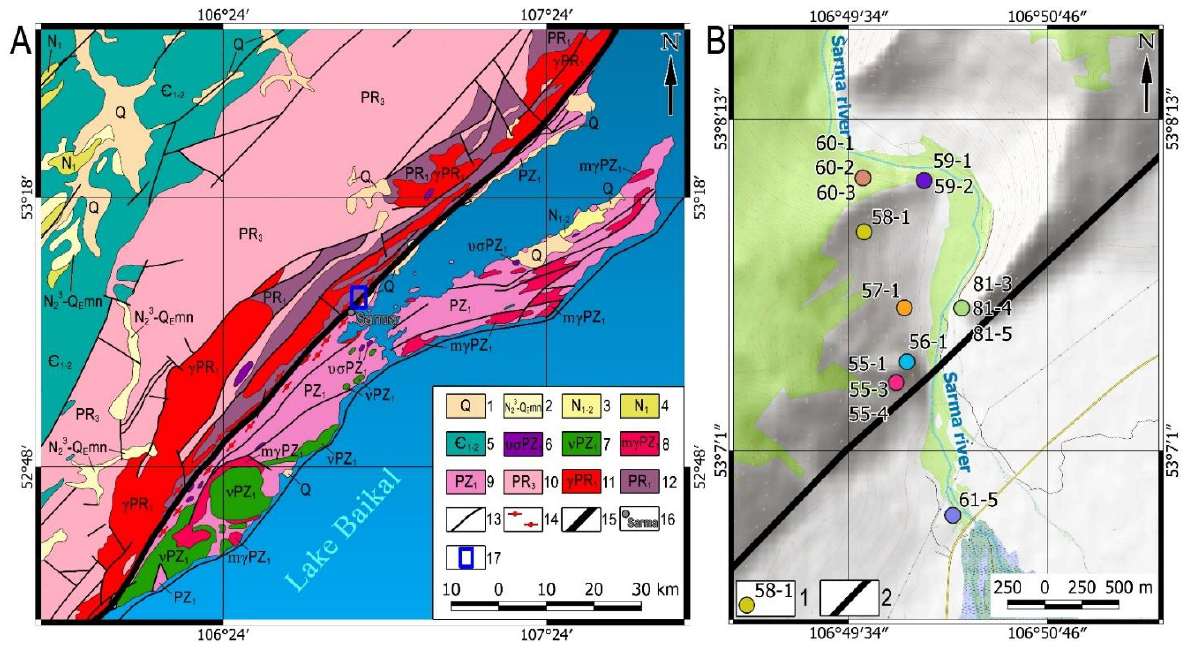
Figure 2. ( A ) Geological map of the Primorsky Fault [74,75,81 – 84]: 1 — beach lacustrine deposits of Lake Baikal and alluvium of river valley terraces; 2 — Manzurka Fm. alluvium; 3 — Golumets Fm. alluvium; 4 — Bayanday Fm. alluvium; 5 — Lower and Middle Cambrian sediments on the Siberian craton; 6 — Atarkhan peridotite – gabbro complex; 7 — Ozersk gabbro – diorite complex; 8 — Olkhon migmatite – granite complex; 9 — Early Paleozoic metamorphic complexes of the Olkhon terrane; 10 — Upper Proterozoic sediments (Baikal Group); 11 — Primorsky granite complex; 12 — Early Pro- terozoic craton basement; 13 — main faults; 14 — blastomylonite from the marginal suture of the Si- berian craton; 15 — Primorsky Fault; 16 — Sarma village; 17 — area of study. ( B ) Scheme of the ori- ented rock samples selection within the Primorsky Fault zone near Sarma village: 1 — sampling points and their numbers; 2 — Primorsky Fault.